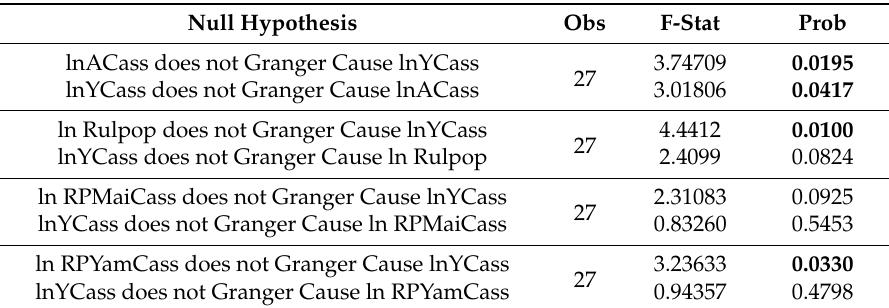
Table 5. Pairwise Granger causality tests (sample: 1978–2009; Lags 5).